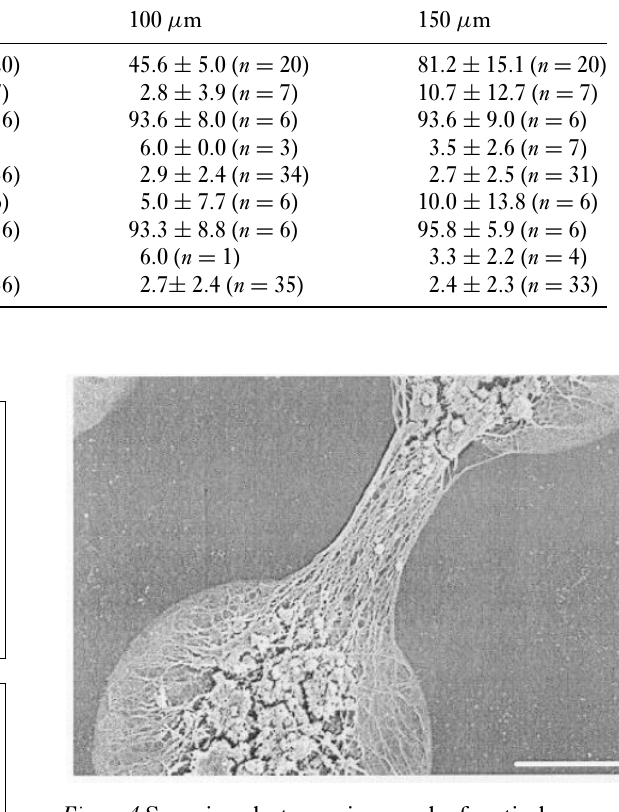
Figure 4 Scanning electron micrograph of cortical neuronal tissue (30 DIV) present on a pattern of PEI circles microprinted onto FC. Diameter of the circular islands is 150 µ m. Spacing distance between circles is 90 µ m, scaling bar = 50 µ m. The micrograph shows a connected pair of islands in